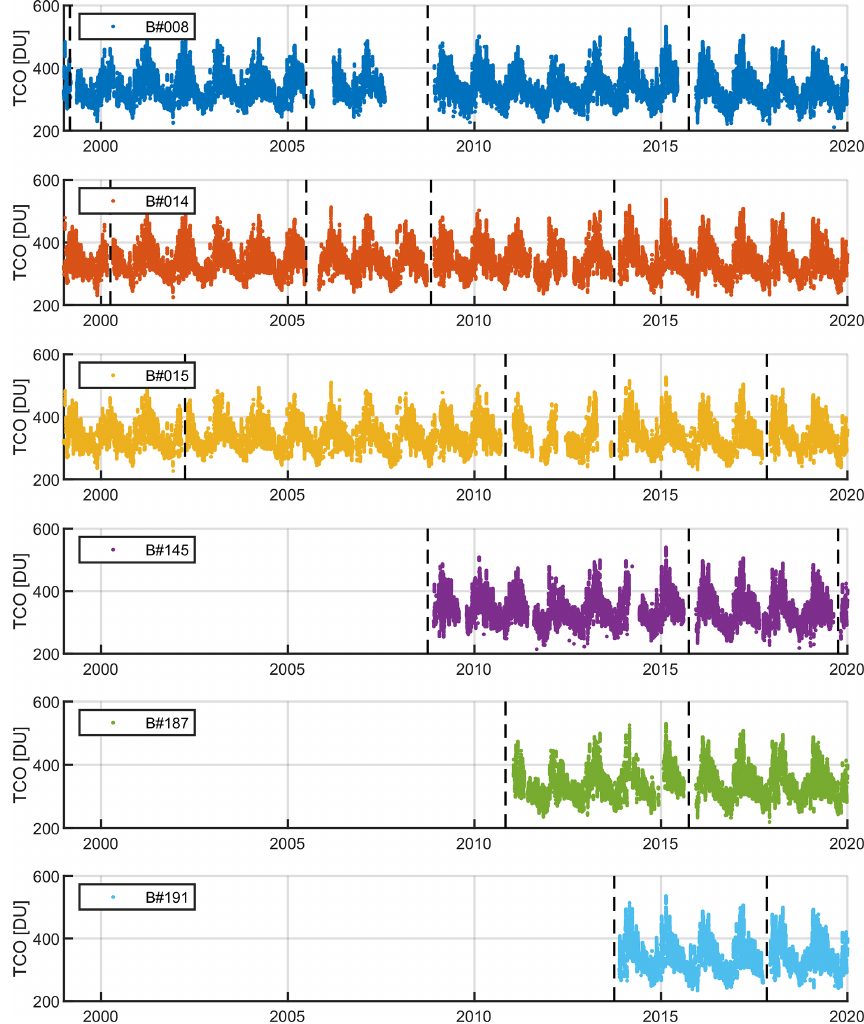
Figure 1. Time series of Brewer reference triads’ total column ozone observations in Toronto. Vertical black dash lines indicate the time of primary calibrations as shown in Table